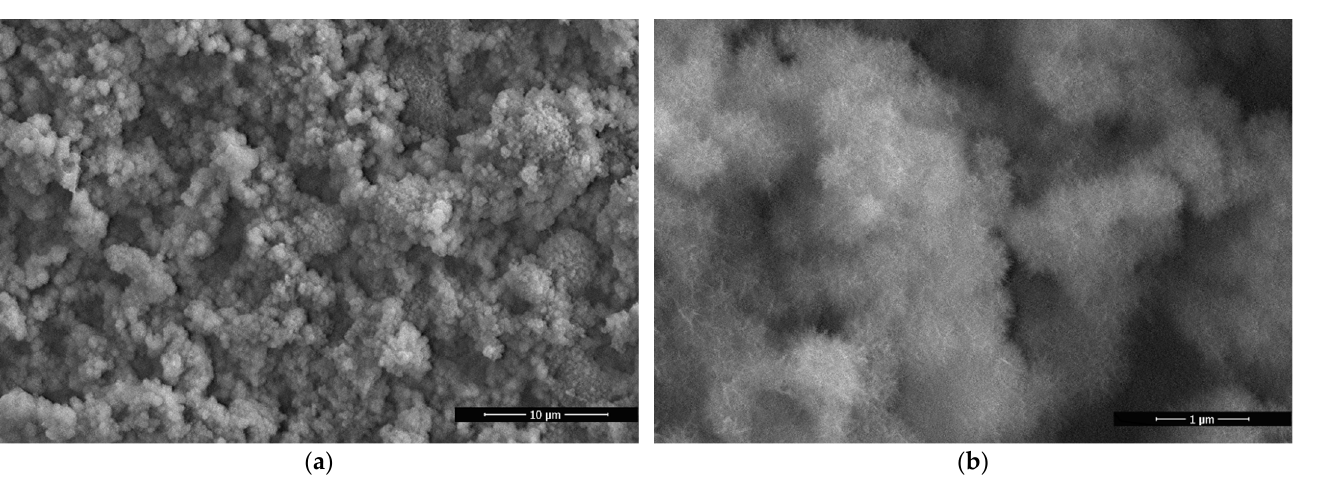
Table 3. Chemical composition of the initial and modified aluminum surface (using the EDS method).